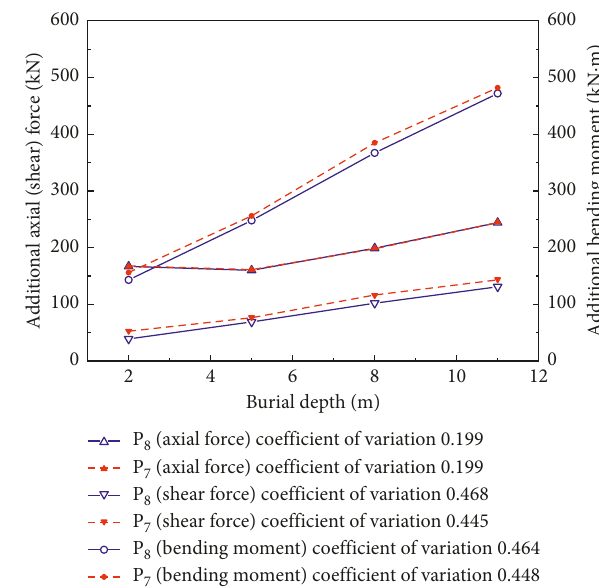
Figure 15: Variations of dynamic internal forces with burial depths at typical sections.